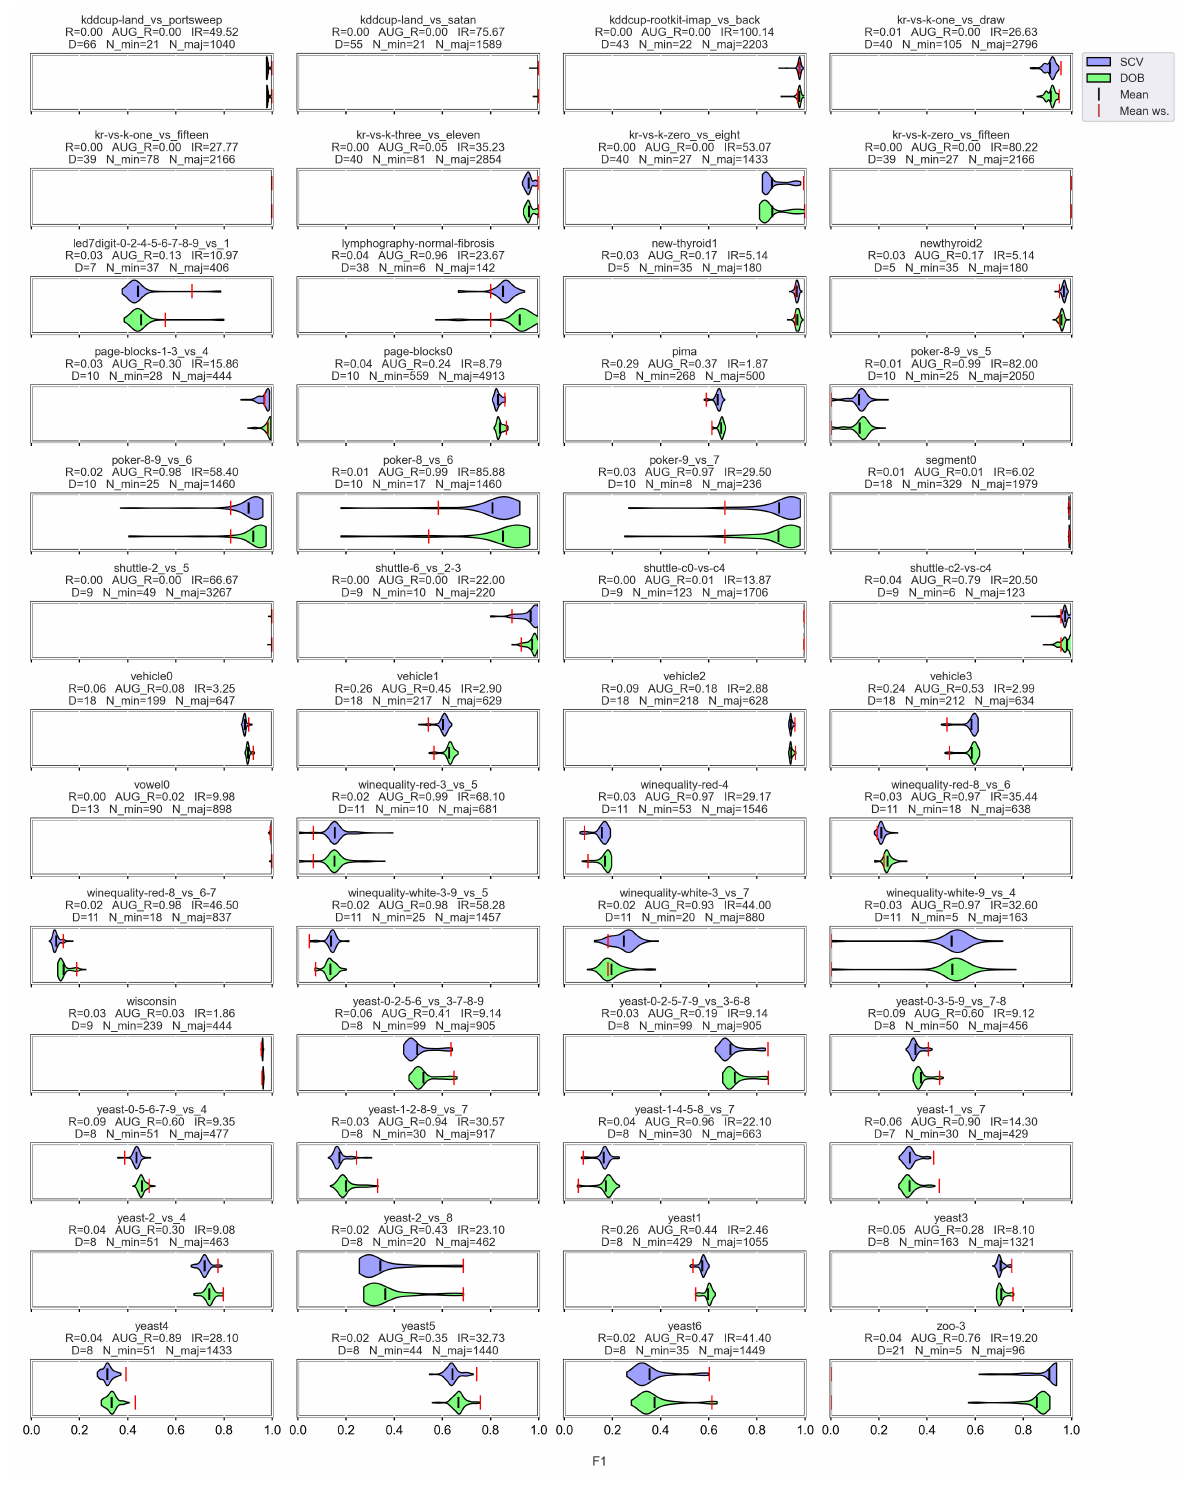
Figure A2. F 1 values resulted by the kNN classifier and the named oversamplers per data set of